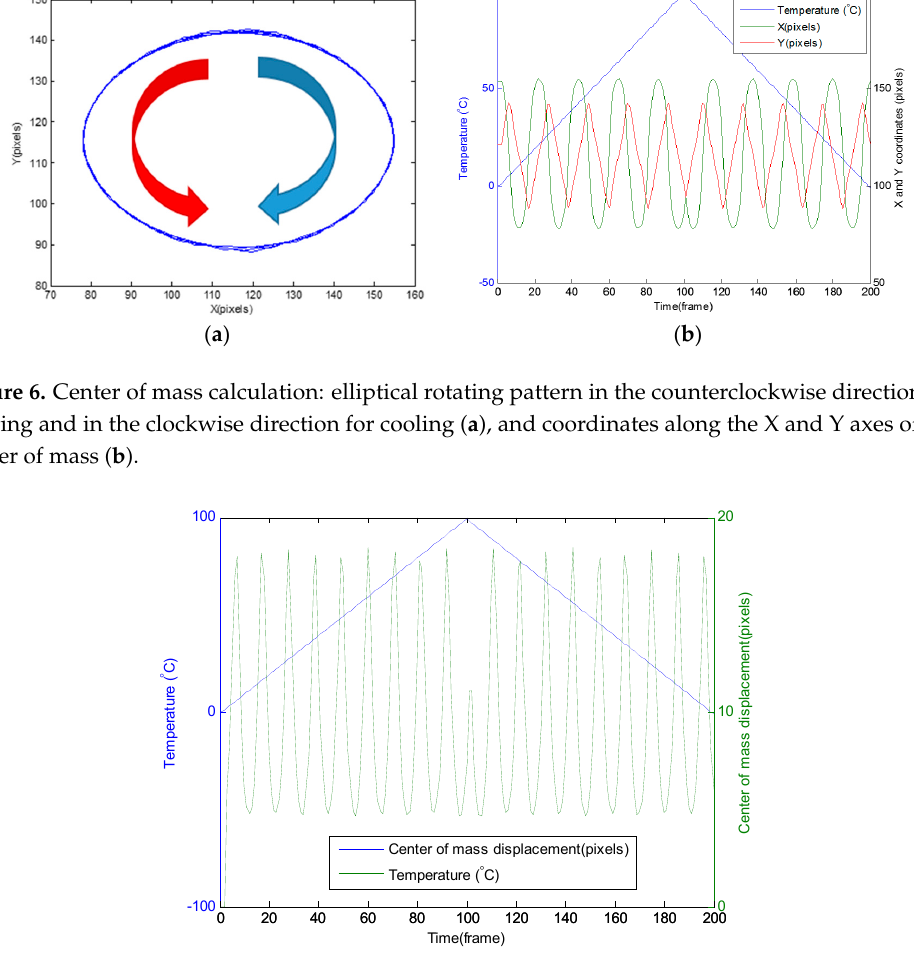
Figure 7. Displacement of the center of gravity of the interference pattern with the temperature variation from 0 °C to 100 °C and then from 100 °C to 0 °C.